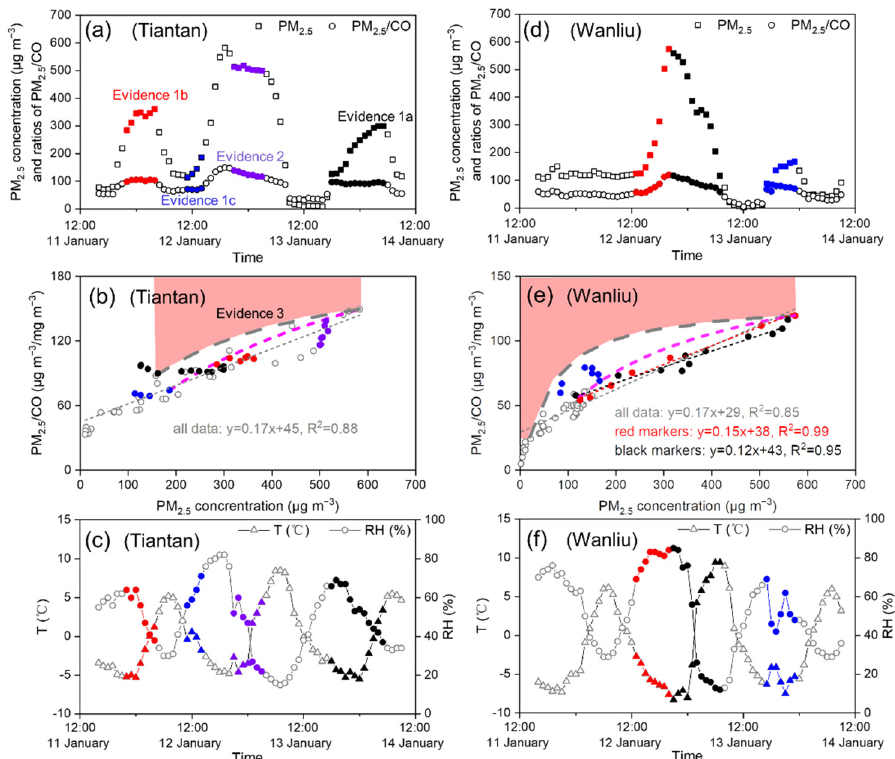
Figure 3. Time series of hourly average mass concentrations of PM 2.5 and PM 2.5 /CO ratios in µ g m − 3 /mg m − 3 ( a ), and their correlation ( b ) and time series of the hourly average of T and RH ( c ) on 9–13 January 2019 in Tiantan; ( d – f ) correspond to ( a – c ), respectively, with the location changed to Wanliu; different colors of full markers ( a – f ) represent data measured at different times; empty markers represent the remaining data; gray dashed line represents the theoretical dilution curve using the approach presented in the text during the decreasing period, red shallow area represents the theoretical dilution area in the presence of ambient FSPM, pink line represents the theoretical mixing curve during the increasing period as discussed in the text.